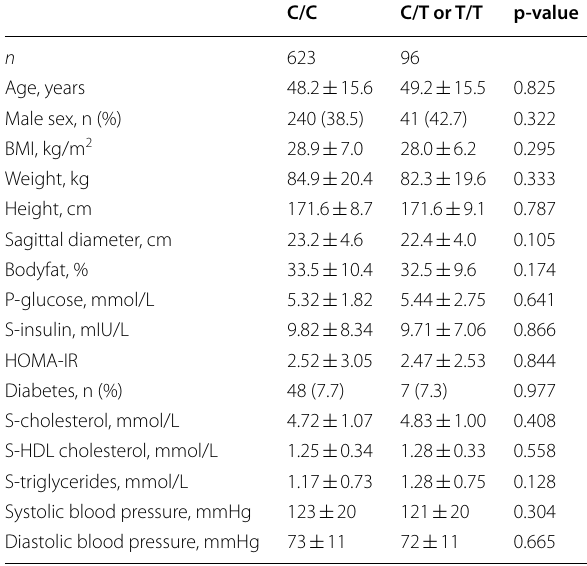
Table 1 Patient characteristics in the SibPair Study